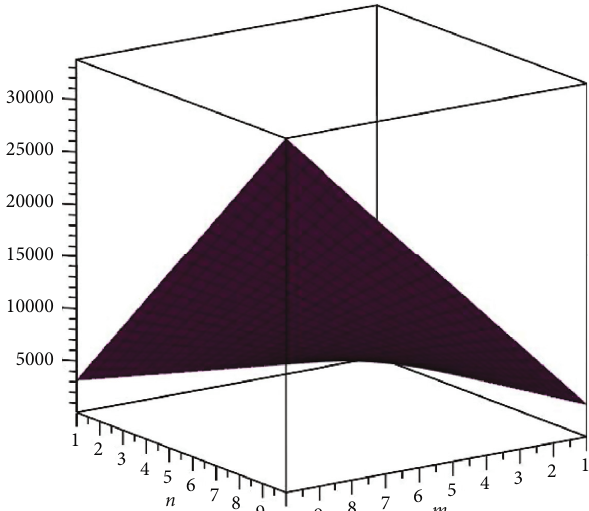
Figure 4: The first Zagreb α -index.